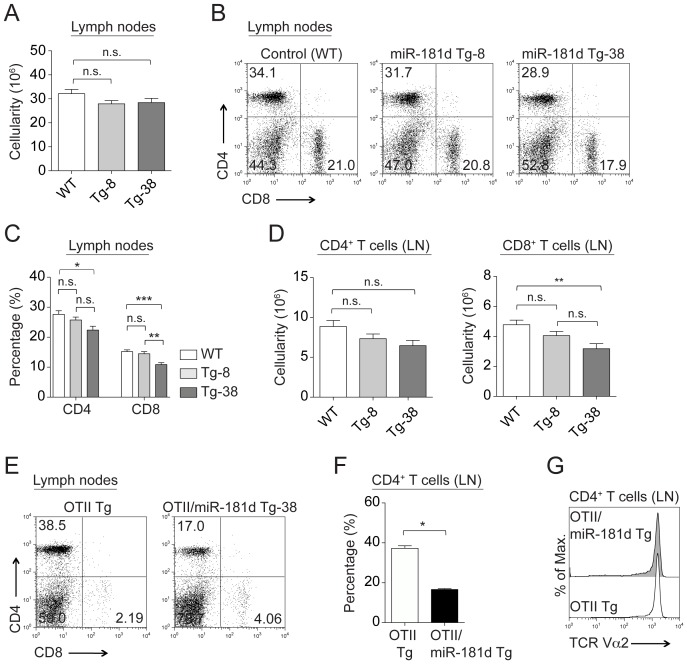
Characterization of peripheral lymphocytes in miR-181d transgenic mice.(A) Total cellularity in the lymph nodes of the control and miR-181d Tg mice. (B) Representative FACS plots of CD4+ and CD8+ T cells in the lymph nodes. (C–D) Average percentages (C) and absolute numbers (D) of CD4+ and CD8+ T cells in the lymph nodes. (A–D) Data are of the mean +/− SEM from the WT (n = 17), Tg-8 (n = 23), and Tg-38 (n = 14) mice (n.s.  =  non-significant, *p<0.05, **p<0.01, ***p<0.001; One-way ANOVA followed by Tukey's post-hoc test). (E) CD4 and CD8 profiles of peripheral T cells from the lymph nodes of the OTII Tg and OTII/miR-181d Tg-38 mice. (F) Bar graph shows average percentages of CD4+ T lymphocytes in the lymph nodes. (G) Surface expression of TCR (TCR Vα2) gated on CD4+ T cells in the lymph nodes of the OTII Tg (dark gray) and OTII/miR-181d Tg-38 mice (black line). (E–G) Data are generated from at least 2 mice per group. Each bar represents the mean +/− SEM values (*p<0.05, **p<0.01, ***p<0.001; Two-tailed unpaired Student's t-test).